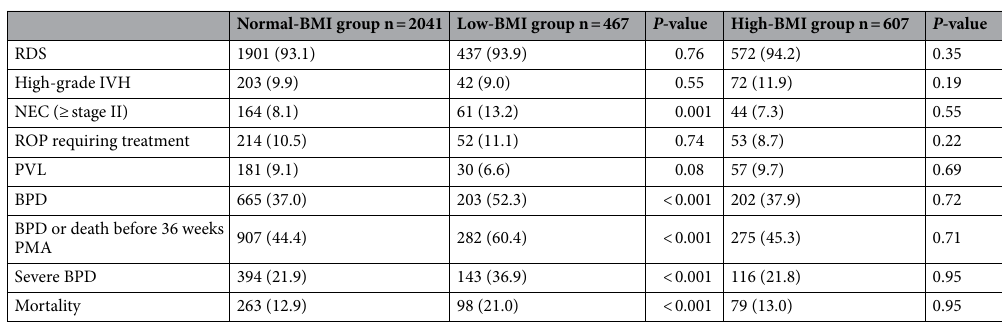
Table 2. Comparisons of neonatal morbidities and mortality between low- and normal-BMI groups and between high- and normal-BMI groups. Data are expressed as n (%), mean ±